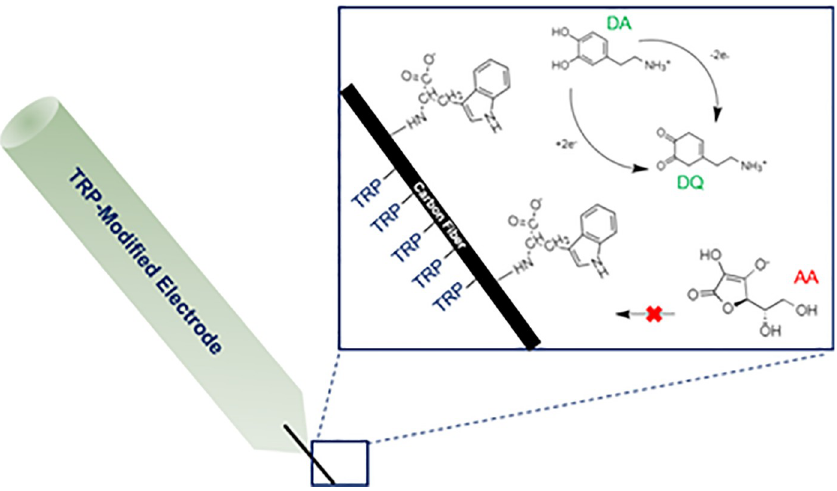
Fig 5. A proposed model for TRP-modification based on carbon–nitrogen binding at the amine group. AA is negatively charged and repelled by the negatively charged TRP surface, whereas positively charged DA is adsorbed.